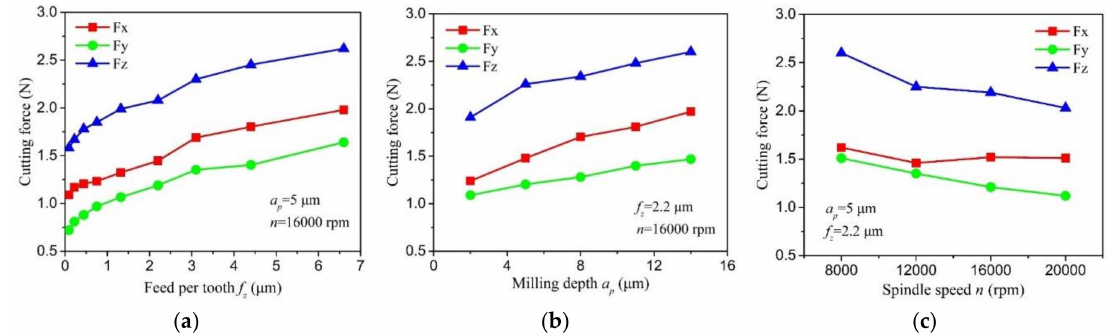
Figure 10. The cutting force curve varies with milling parameters: ( a ) cutting force versus feed per tooth, ( b ) cutting force versus depth of cut, ( c ) cutting force versus spindle